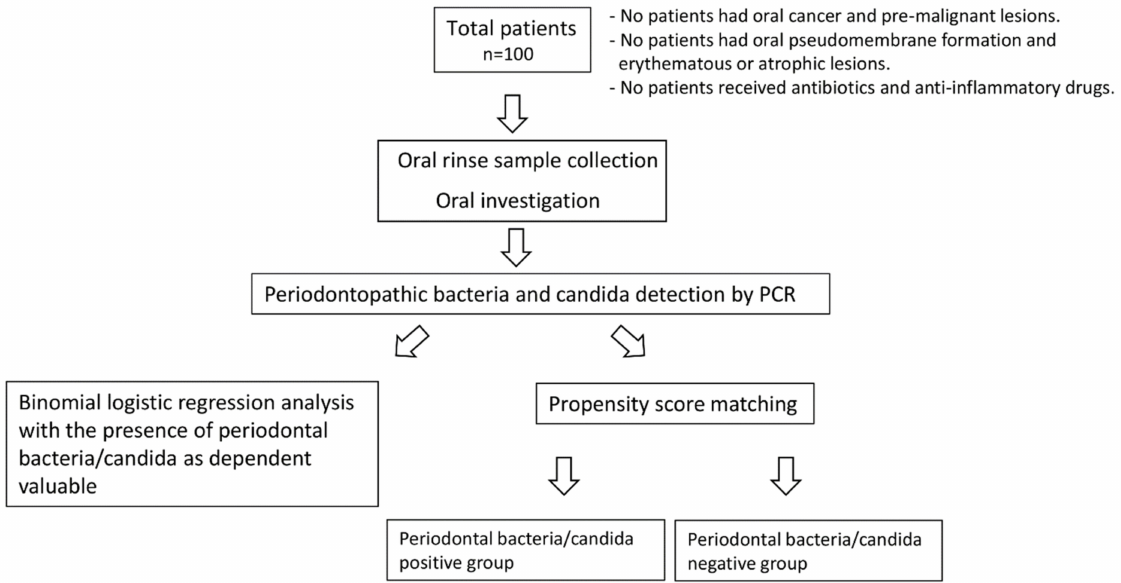
Figure 1. Schematic diagram of this